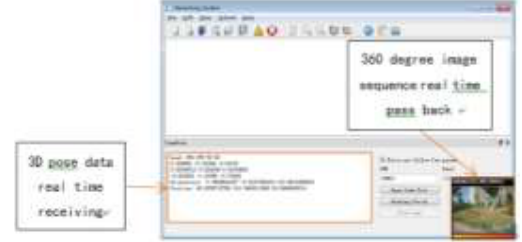
Figure 8. Data process interface when outdoor shooting